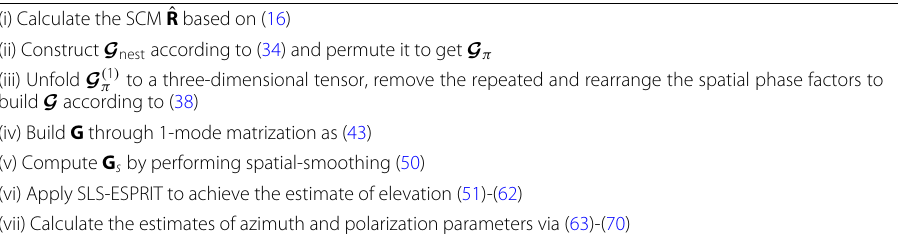
Table 1 Algorithm of Joint Elevation-Azimuth-Polarization